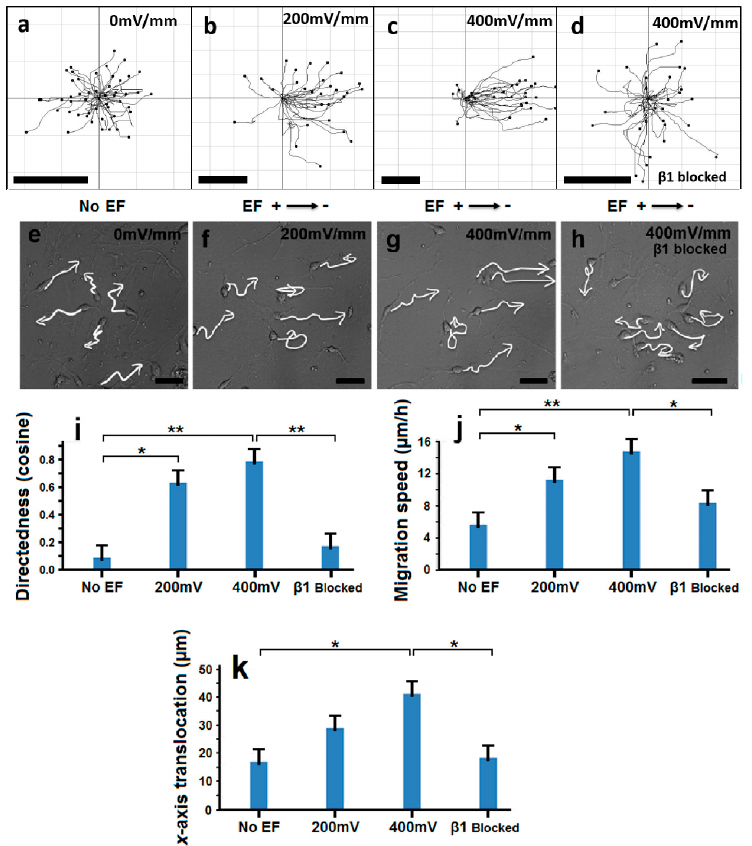
Figure 2. Electric field (EF)-directed OPC migration is dependent on β 1 integrin. Recorded migration trajectories of OPCs over a 4 h period under different treatment conditions: no EF ( a ), 200 mV/mm ( b ), 400 mV/mm ( c ), and 400 mV/mm with β 1 integrin inhibition ( d ). The migration trajectories of OPCs over a 4 h period are described by the white lines and arrows: no EF ( e ), 200 mV/mm ( f ), 400 mV/mm ( g ), and 400 mV/mm with β 1 integrin inhibition ( h ). The value of the migration directedness (the average cosine of all angles measured between the path of cell migration and the x -axis) represents the net OPC translocation towards the cathode measured over a 4 h period. OPCs that were exposed to 200 and 400 mV/mm EFs displayed a significantly greater directedness compared to OPCs that were either not EF-treated, or were treated to a 400 mV/mm EF with β 1 integrin inhibition ( i ). A similar pattern is observed regarding OPC migration speed ( j ). OPCs exposed to a 400 mV/mm EF displayed greater x -axis translocation towards the cathode when compared to OPCs that were either not EF-treated, or were treated to a 400 mV/mm EF with β 1 integrin inhibition ( k ). The starting points of the all recorded migration trajectories were set at the origin of the x - y axes (0, 0). Refer to Supplemental Videos 1–4. (* p < 0.05; ** p < 0.01). Scale bar = 50 μ m.